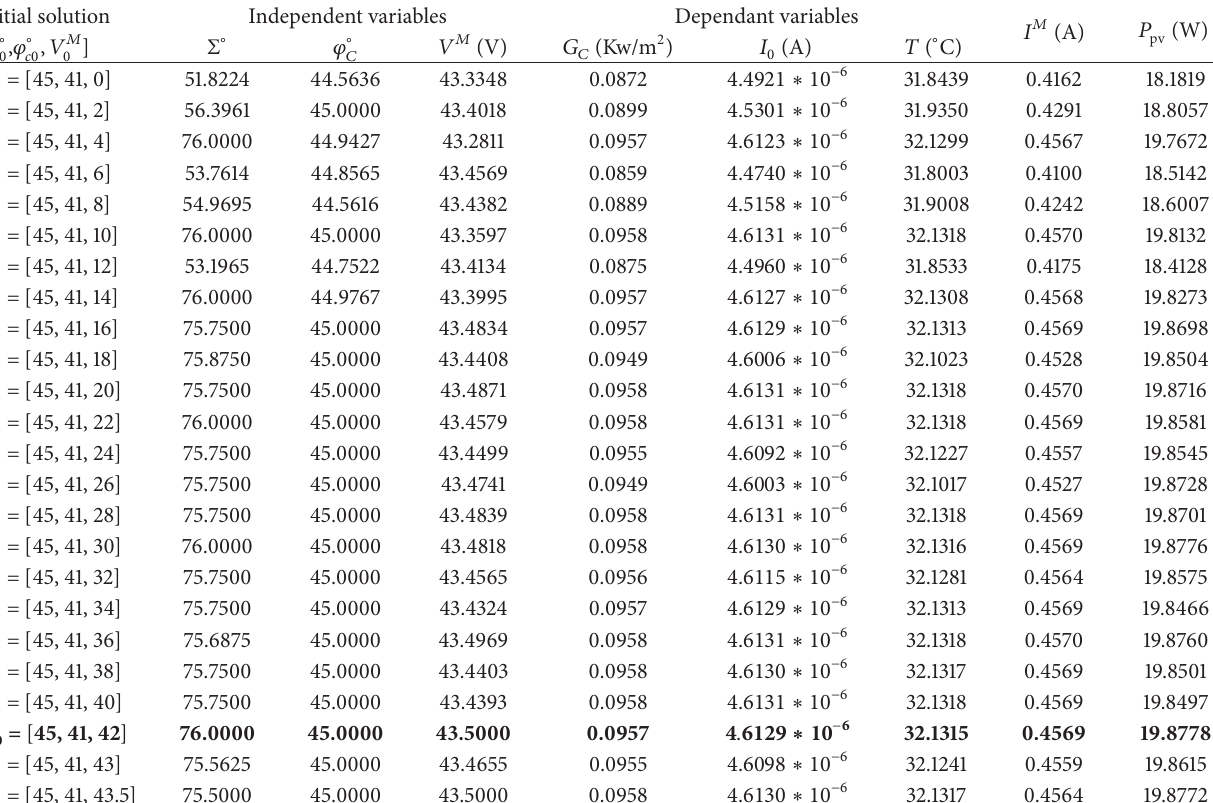
Table 4: Effect of changing the initial module voltage on the module power at 6:10 AM.